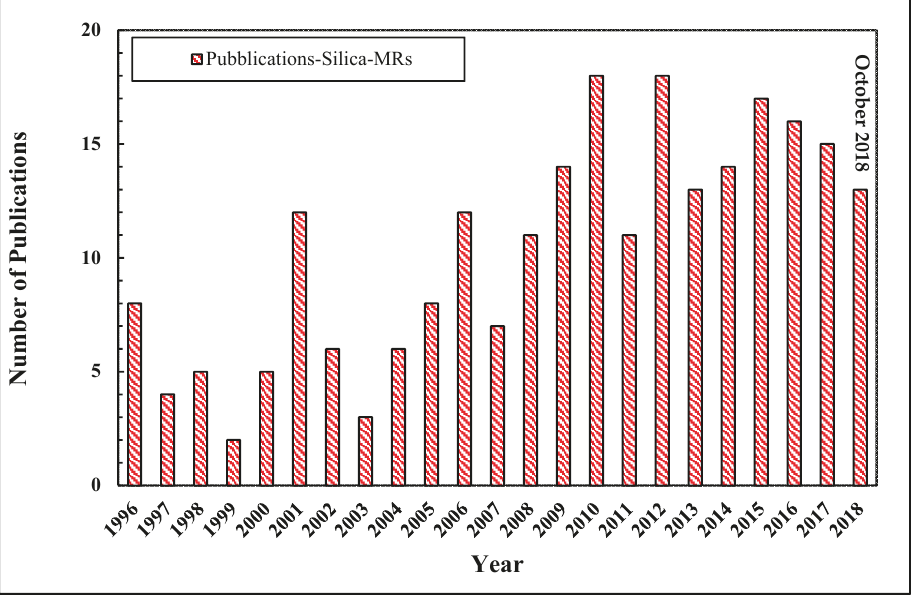
Figure 7. Trend of scientific publications for the silica MRs versus year, Scopus database: www.scopus.com.